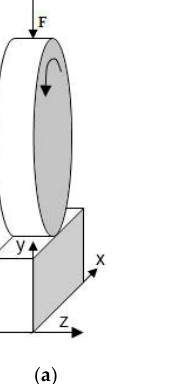
Figure 1. Schemes of the mechanical loading during friction ( a ) and computational domain ( b ).